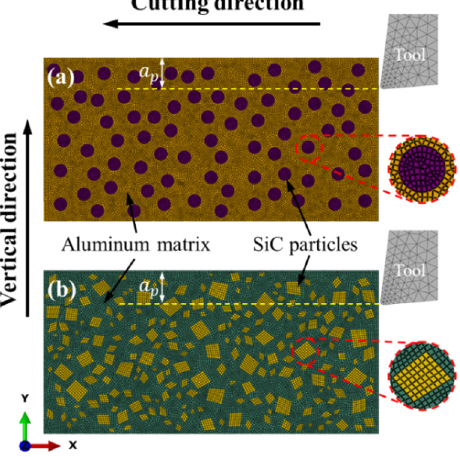
Figure 2. 2D mesoscopic-based finite element (FE) model setup for orthogonal SiC p/Al composites reinforced with different particle shapes: ( a ) circular particles; ( b ) irregular polygonal particles.